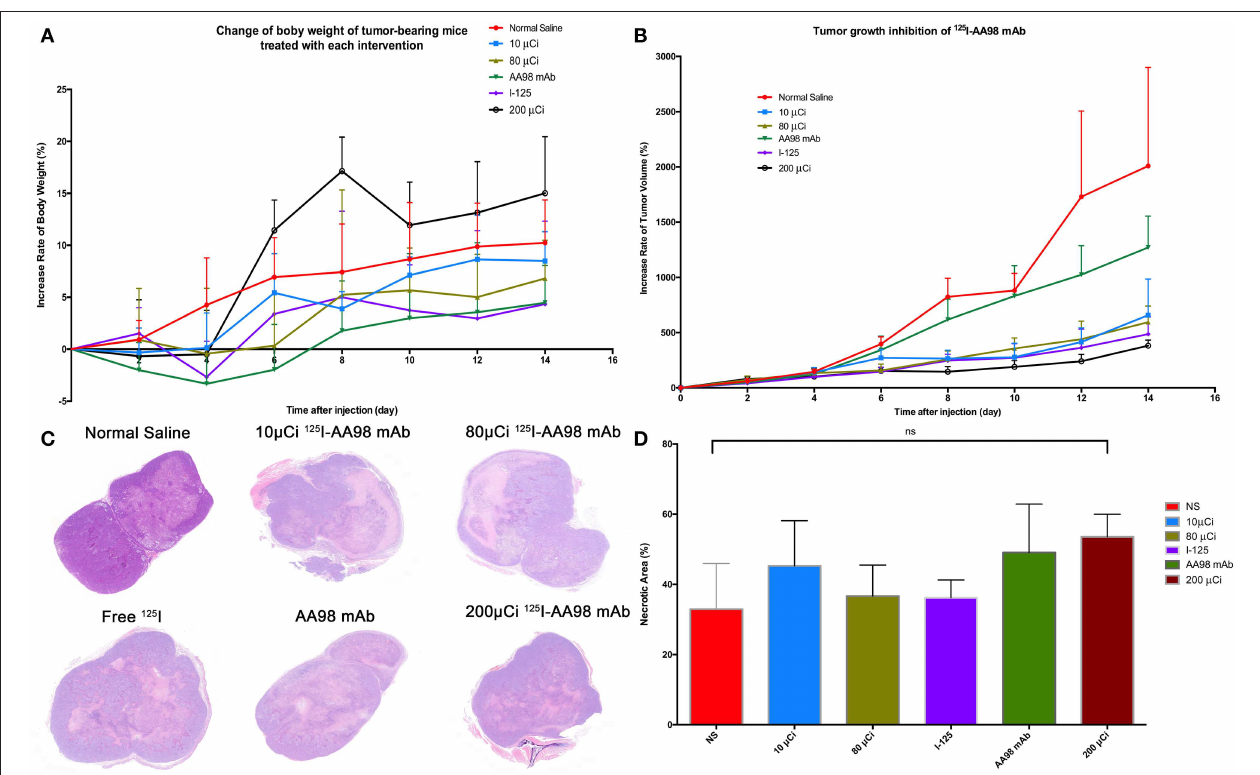
FIGURE 5 | Fourteen days surveillance after intratumoral injection among the six groups and HE staining in HCC xenograft mice models. (A) Change of percentage of body weight in HCC xenograft mice models was calculated. (B) Change of percentage of tumor size in HCC xenograft mice models was documented. (C) Photographs of HE staining for HCC tumor 7 days after intratumoral injection in each group. (D) Multiple comparisons of average necrotic area of HCC tumor were performed among the six